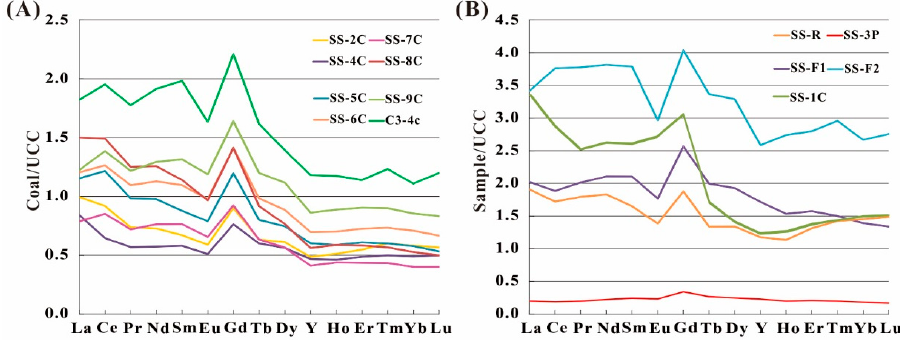
Figure 3. Distribution patterns of rare earth elements (REE) of samples in the Songshao coal mine. ( A ) Plots for the Songshao coal in comparison with C3-4c from the Xinde Mine. ( B ) Plots of SS-1C, roof and floor, and parting from the Songshao Coal Mine. REE are normalized by upper continental crust (Taylor and McLennan [32]).